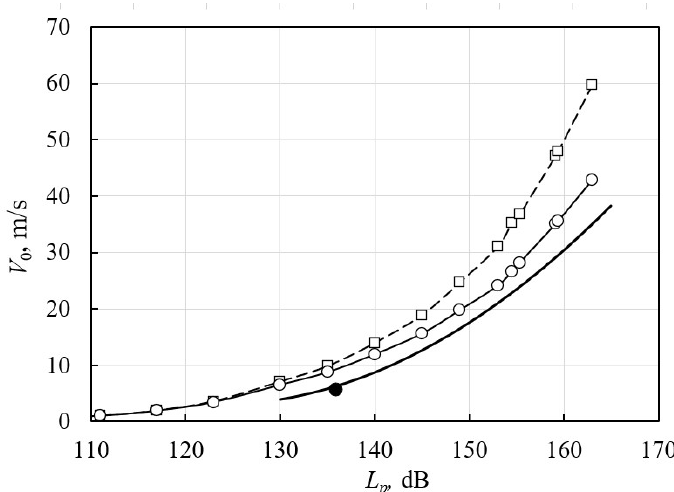
Figure 10. Dependence of the oscillation velocity in the resonator neck on SPL obtained by the two- microphone method (-□-), measurements of the sound pressure in the chamber (- ○ -), Pitot tube measurements (–), and measurement based on the visualization method